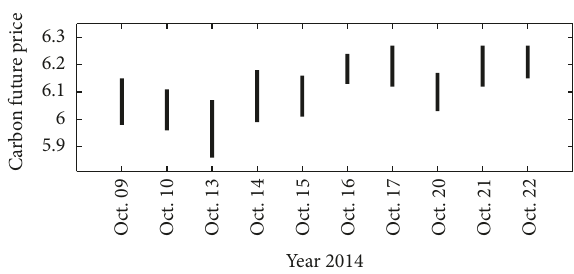
Figure 1: Daily interval-valued carbon futures